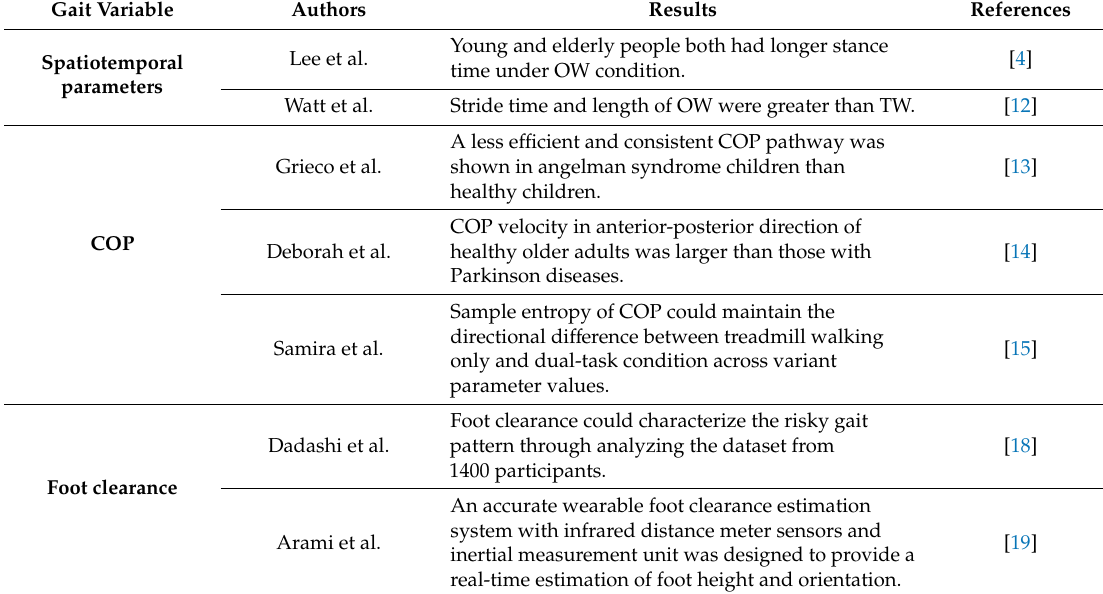
Table 1. Several related studies about gait